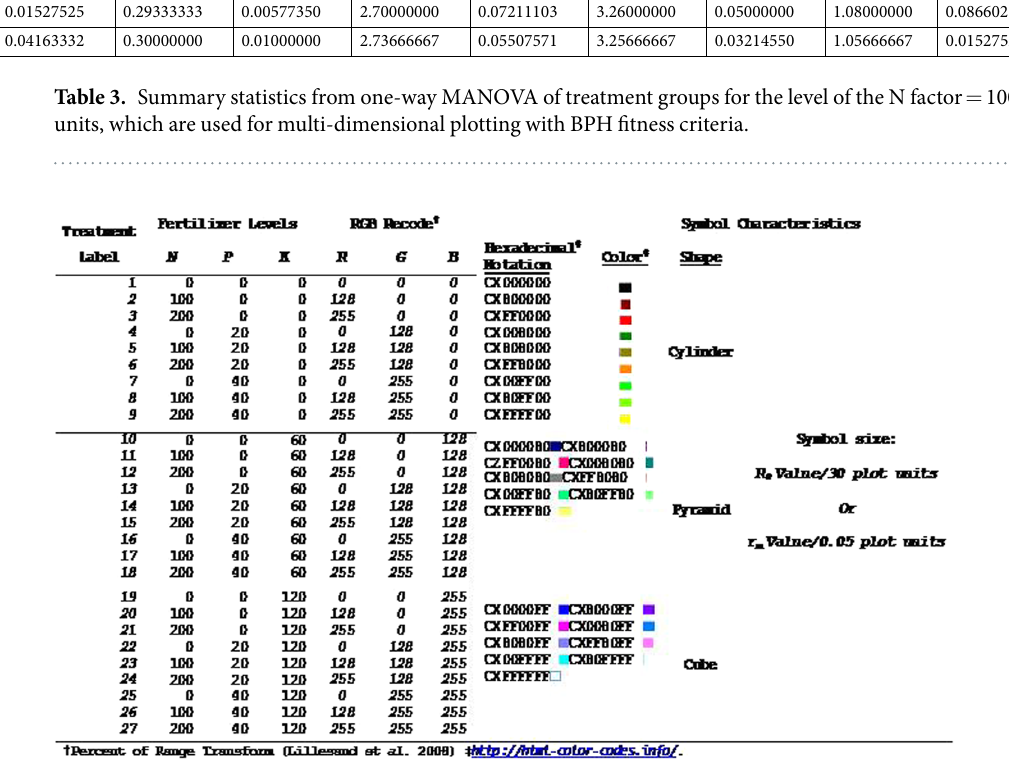
Figure 9. Legend for 3 - D graphics and symbology characteristics for fertilizers, life history traits of BPH and bioassay